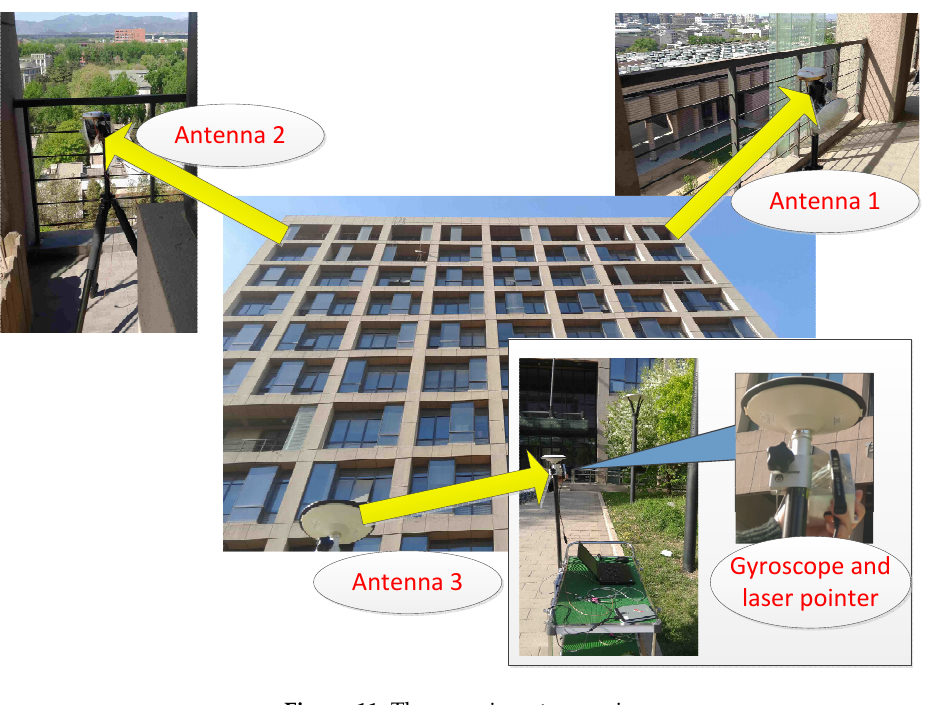
Figure 11. The experiment scenario.